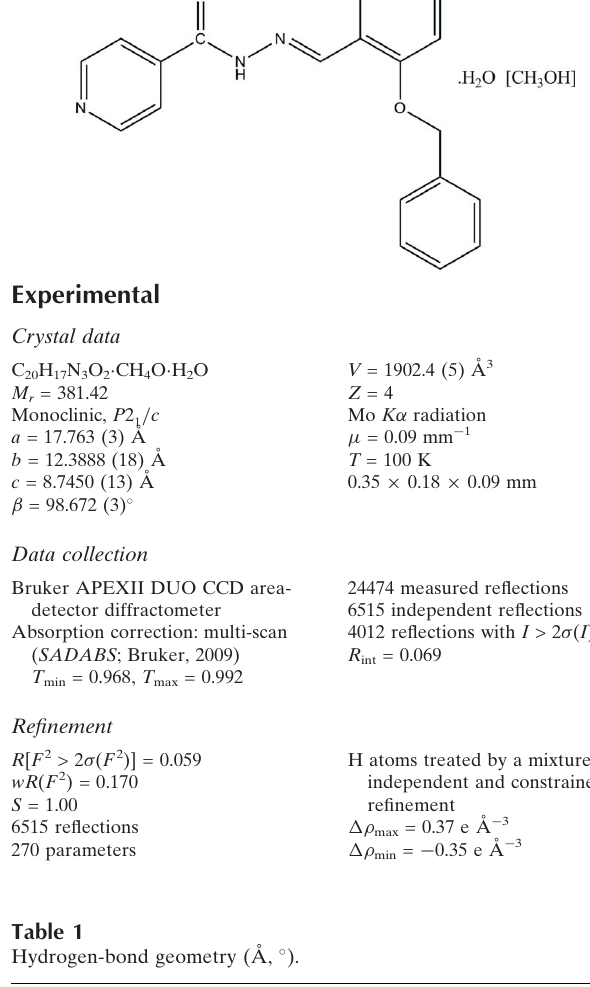
Hydrogen-bond geometry (A˚ , (cid:3) ). D —H (cid:2)(cid:2)(cid:2) A D